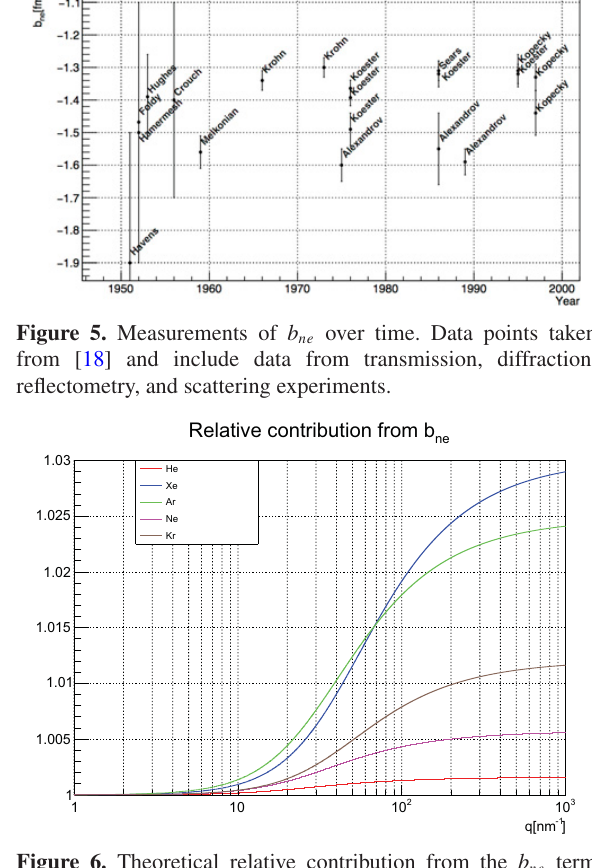
Figure 6. Theoretical relative contribution from the b ne term in the neutron-noble gas differential cross section over the q spectrum measured on NOVA at BL21 at